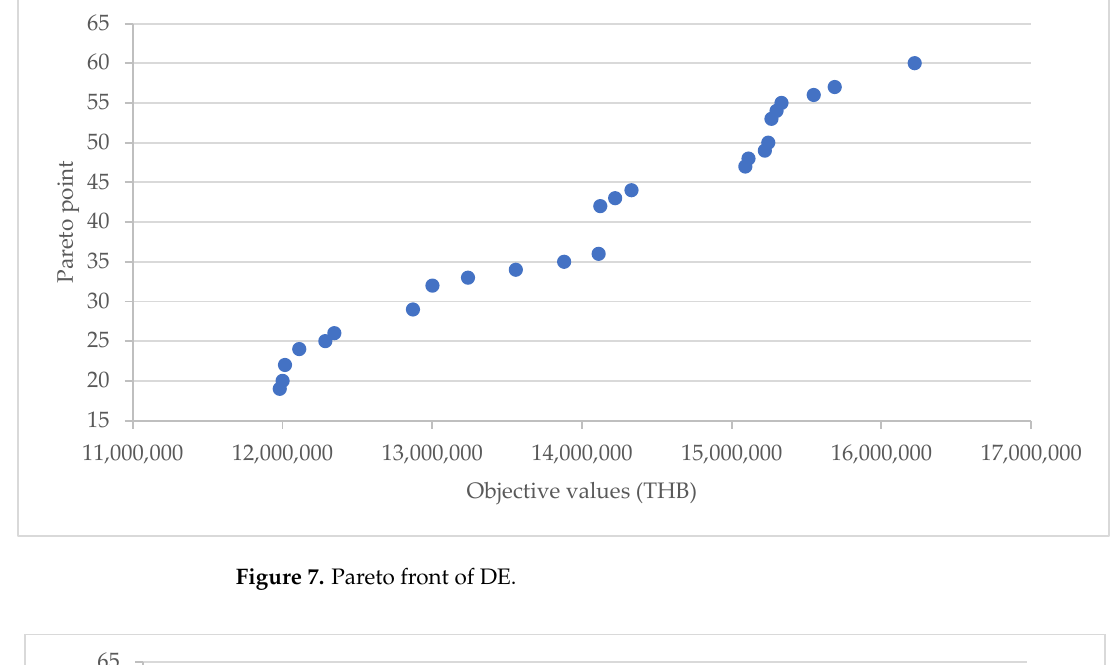
Table 23. Computational results of the case study.